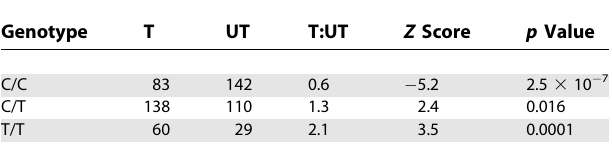
Table 2. Case-Control and Family-Based Genotypic Risk for HLA- DRB1 in UK SLE